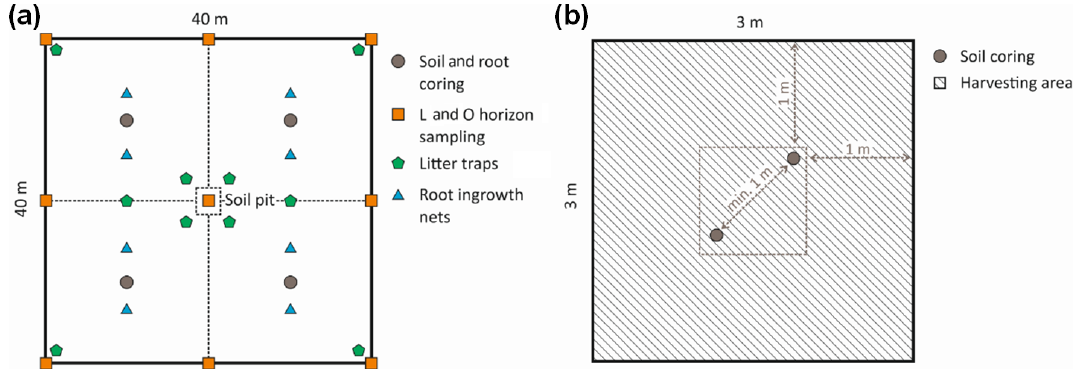
Figure 5. Overview of forest (a) and cropland (b) plot sampling design. Forest plots were subdivided into four 20m × 20m subplots, and one soil profile pit was established per topographic position in each geochemical region for one of three replicate